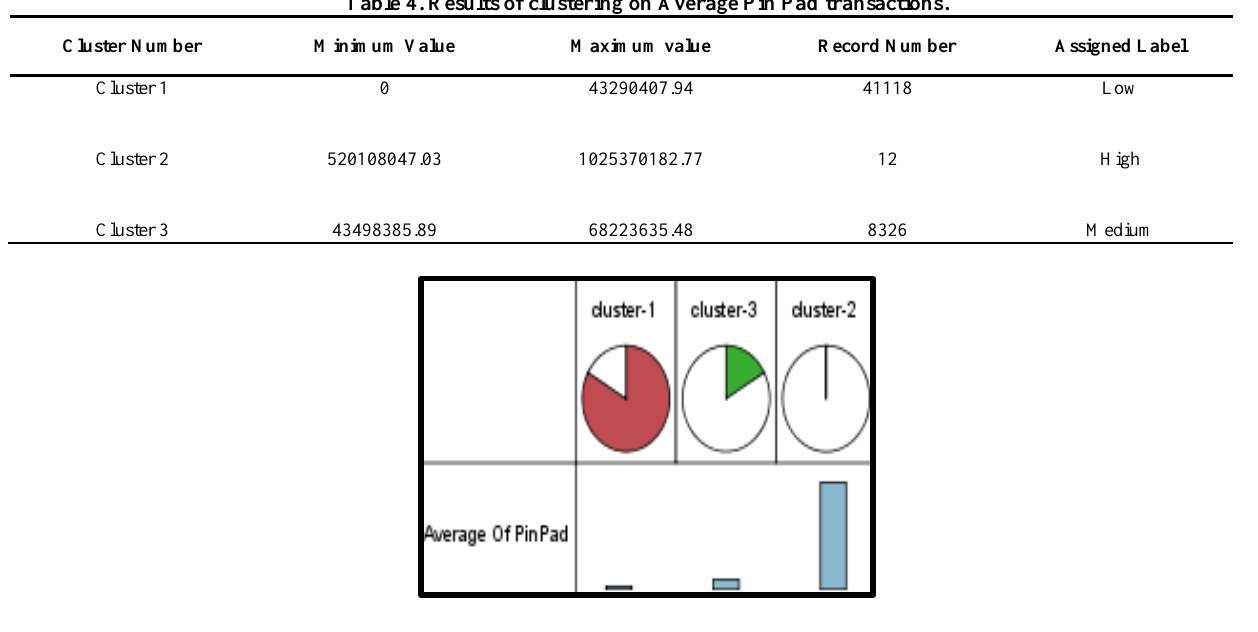
Figure 5. Clusters of variable “Average Amount of PinPad